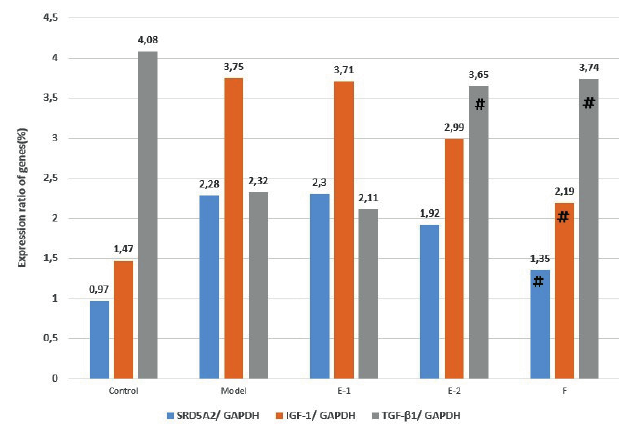
FIGURE 3 - Expression ratio of SRD5A2, IGF-1 and TGF- β 1. Model: BPH, E-1: Extract-30 mg/kg, E-2: Extract-60 mg/kg, F: Finasteride-10 mg/kg. The data were stated as mean ± SE. Superscript sign shows significant difference: #–from Model, #p <